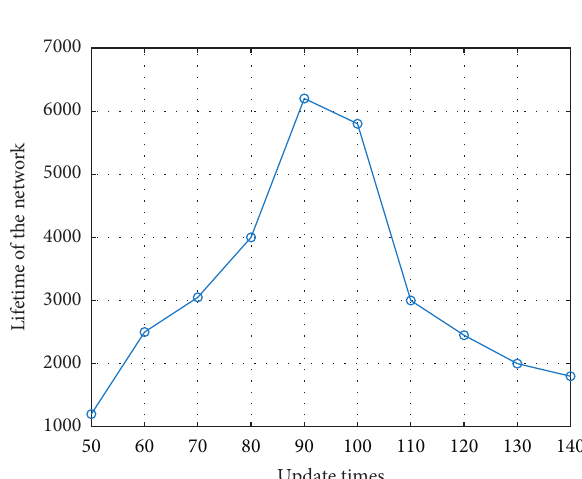
Figure 7: Relationship between the update rounds and the lifetime of the network.